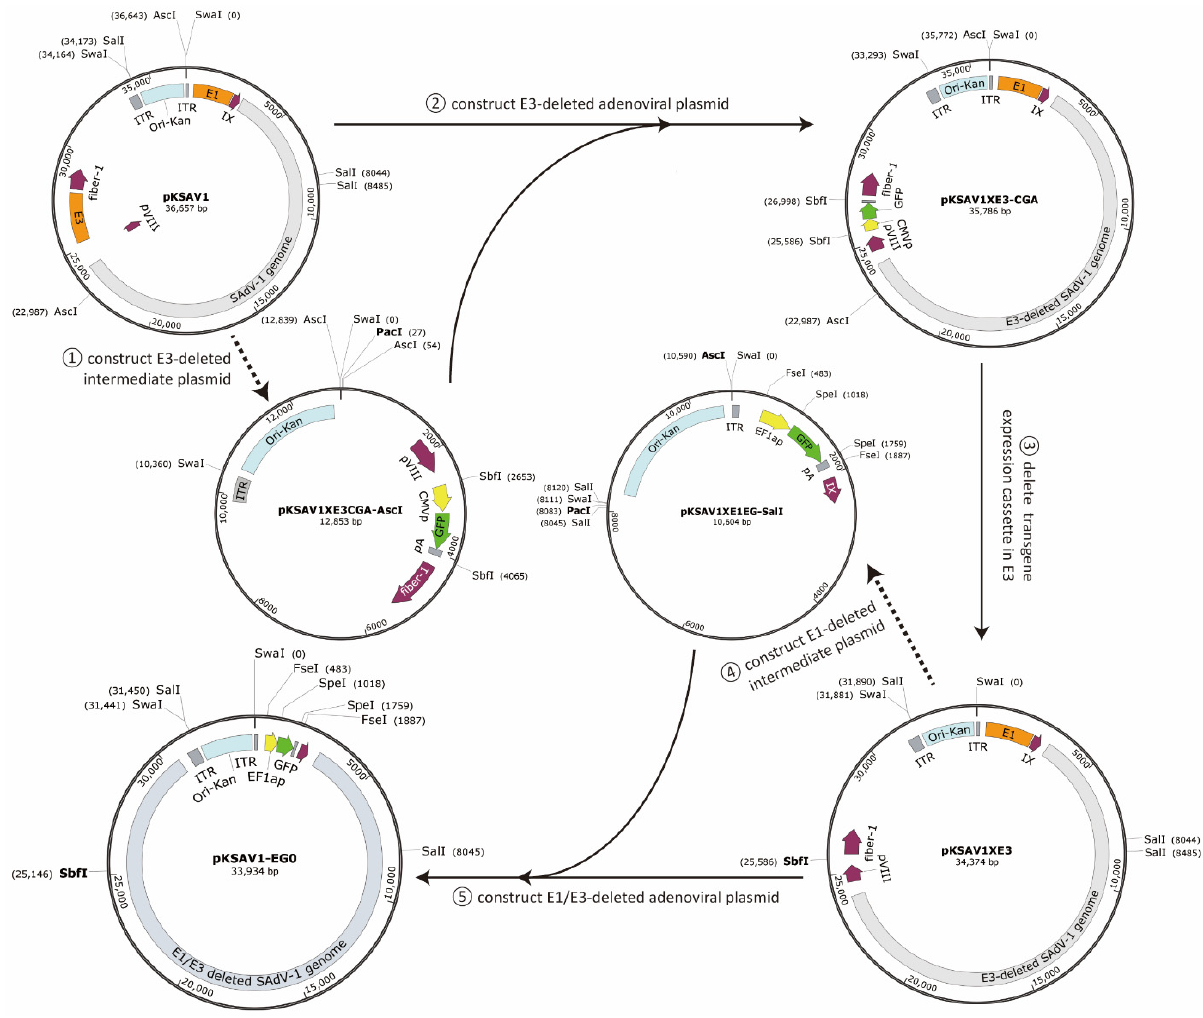
Figure 1. Schematic diagram for constructing E3-deleted and E1/E3-deleted SAdV-1 adenoviral vec-